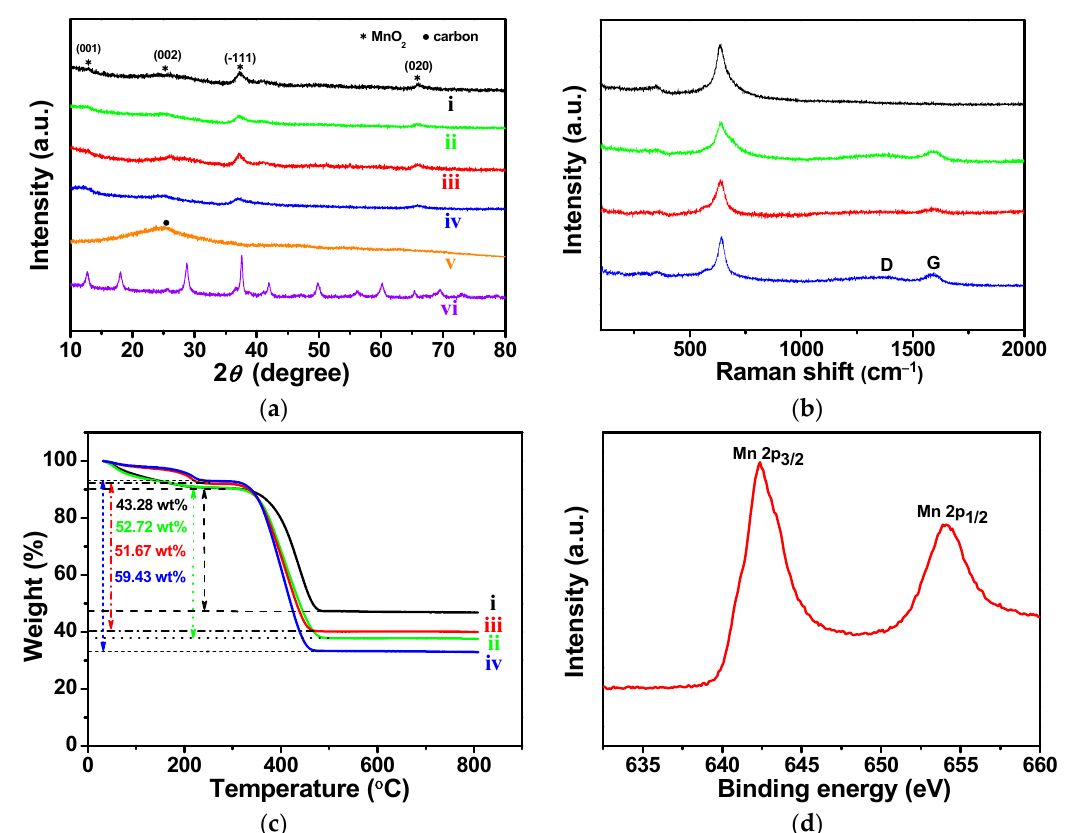
Figure 5. ( a ) X-ray diffraction patterns, ( b ) Raman spectra and ( c ) TGA curves of the samples. Curve i: MnO 2 -TiO 2 -carbon-47.28%; curve ii MnO 2 -TiO 2 -carbon-37.81%: curve iii MnO 2 -carbon-40.15%; curve iv: MnO 2 -carbon-33.30%; curve v: TiO 2 -carbon; curve vi: MnO 2 -NPs. ( d ) High-resolution XPS spectra of Mn 2p regions of the MnO 2 -TiO 2 -carbon-47.28% composite.